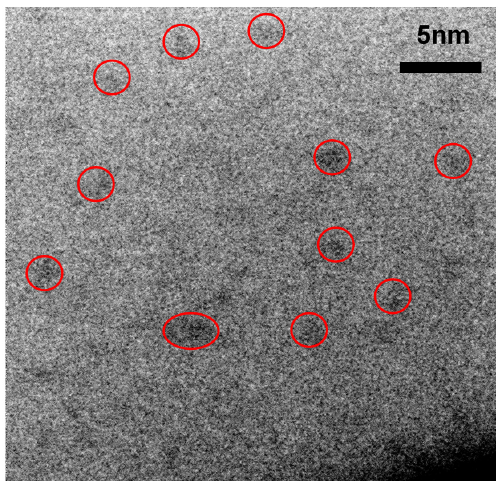
Figure 15. HRTEM micrograph of the D1SiO x film.